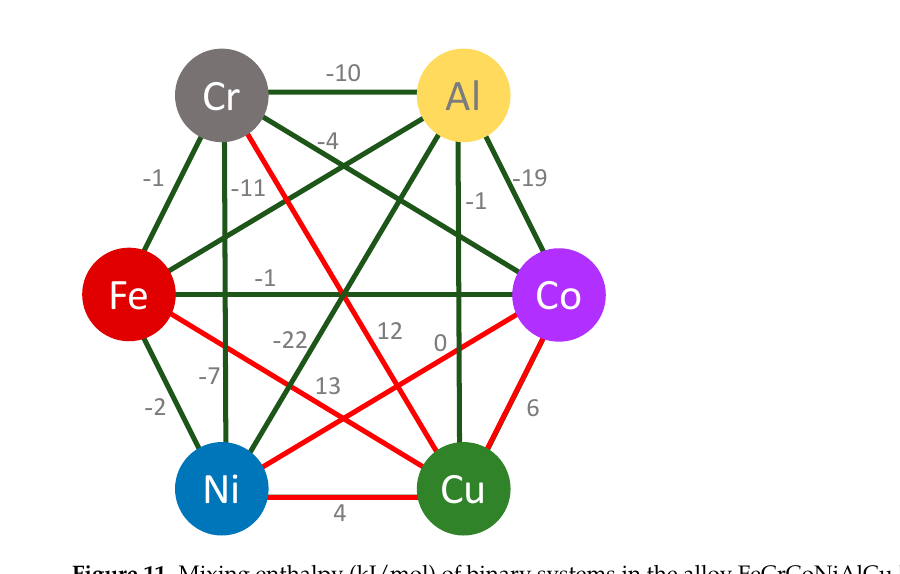
Figure 11. Mixing enthalpy (kJ/mol) of binary systems in the alloy FeCrCoNiAlCu [44]. BCC-B2 phase separation could also explain the presence of a peak corresponding with a FCC phase in the XRD diffractograms of P&S and SPS samples (Figures 6 and 7). The separation of the B2 phase decreases the Al content in the BCC matrix, the Al content being a key factor of phase formation in the HEAs of the FeCrCoNi family.